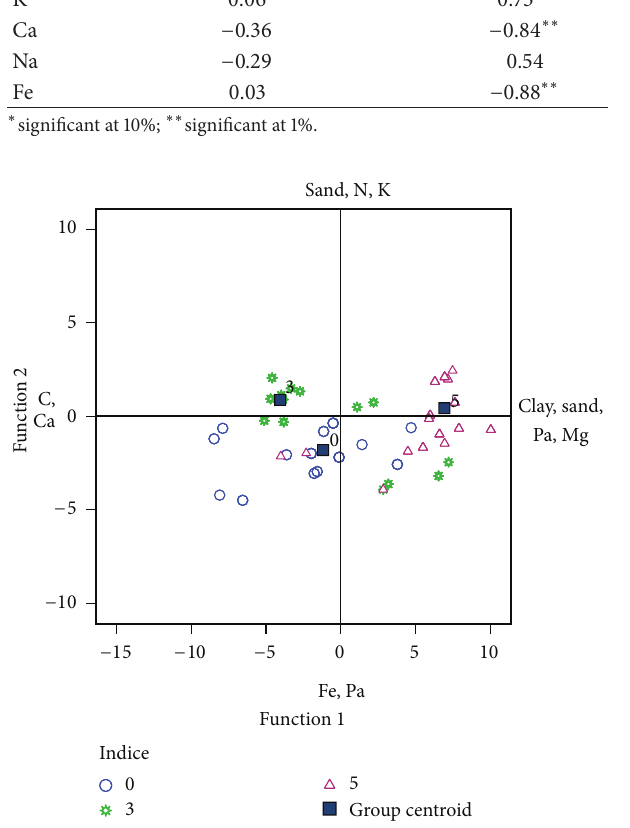
Figure 3: Canonical function discrimination of Imperata abun- dance according to soil parameters.